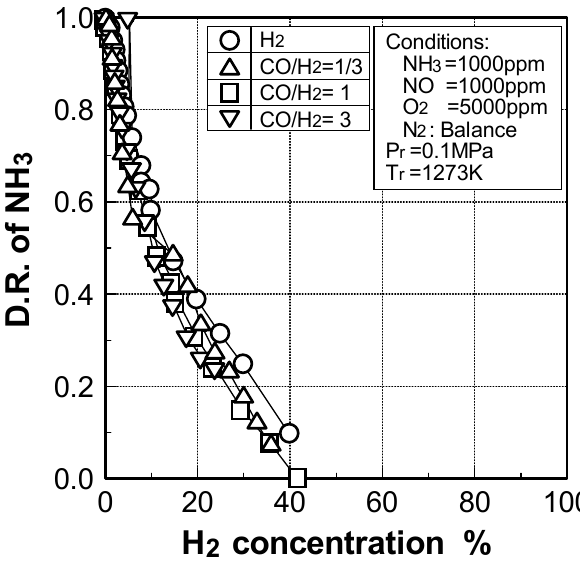
Figure 37. Relationship between decomposition ratio of NH combustible components as defined by experiments.